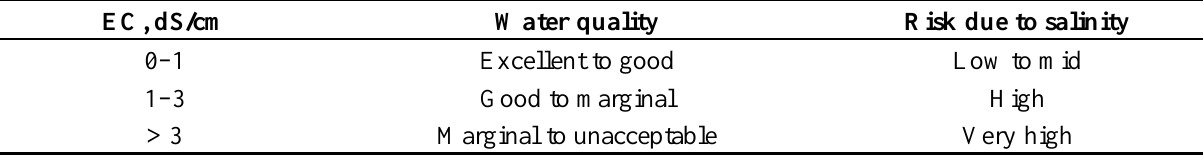
Table 4. Irrigation water quality as a function of its salinity (Food and Agriculture Organization,